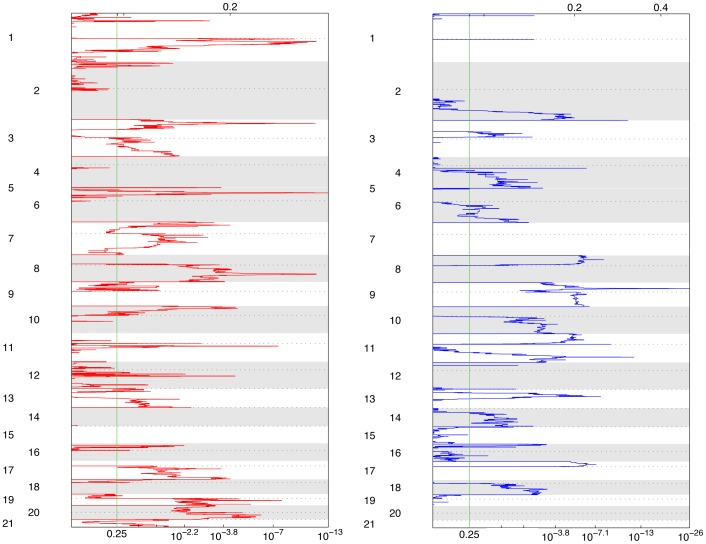
GISTIC plot of genomic regions with CN gain or loss from the MIP analysis on 73 urothelial carcinoma specimens.The 21 autosomes are shown on the y axis, and q values indicating statistical significance from the GISTIC analysis are plotted on the x axis for regions of copy number gain (red at left) and loss (blue at right).